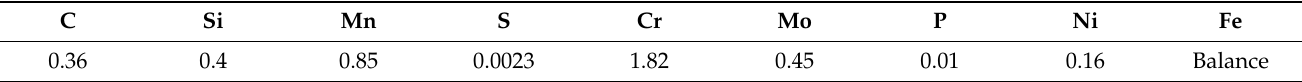
Table 1. Nominal composition of the studied steel